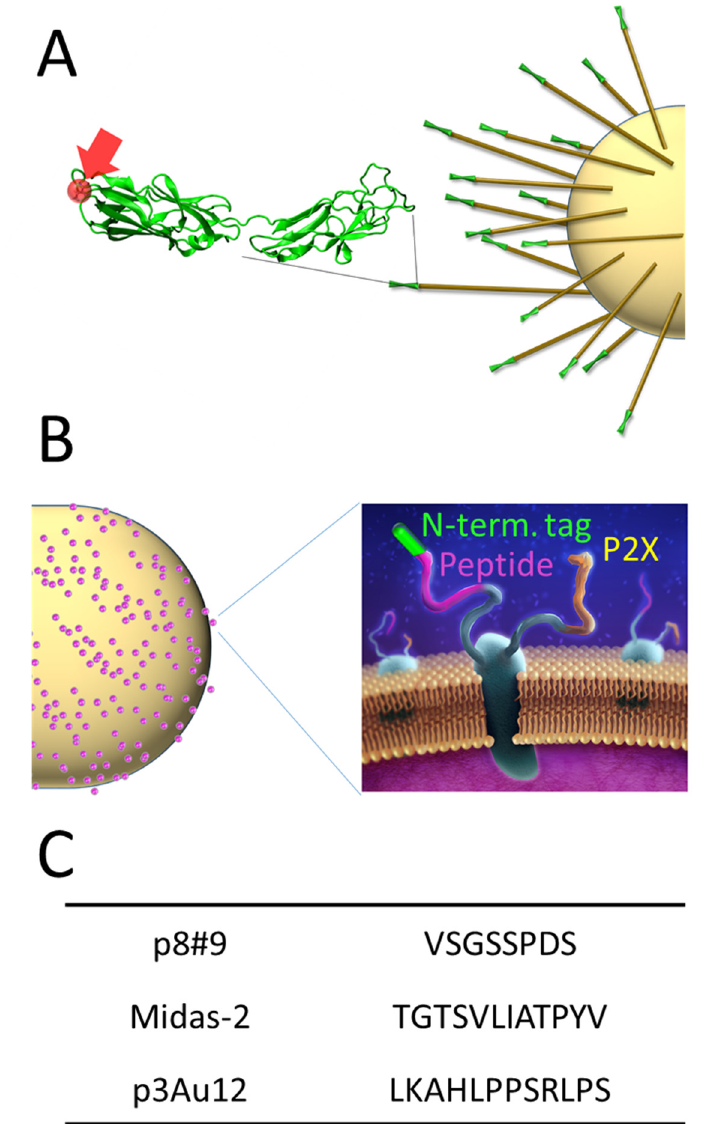
Figure 1. Schematic of the two scaffolds used for controlling the affinity of E. coli towards gold substrate, FimH ( A ) and eCPX ( B ). The peptide insertion site in FimH is shown by the red arrow and ball. In eCPX, the peptide location is shown in purple, while the P2X is shown in yellow and the end tag that can be functionalized with cysteine shown in green. ( C ) Gold binding peptides taken from the literature for use in these experiments.